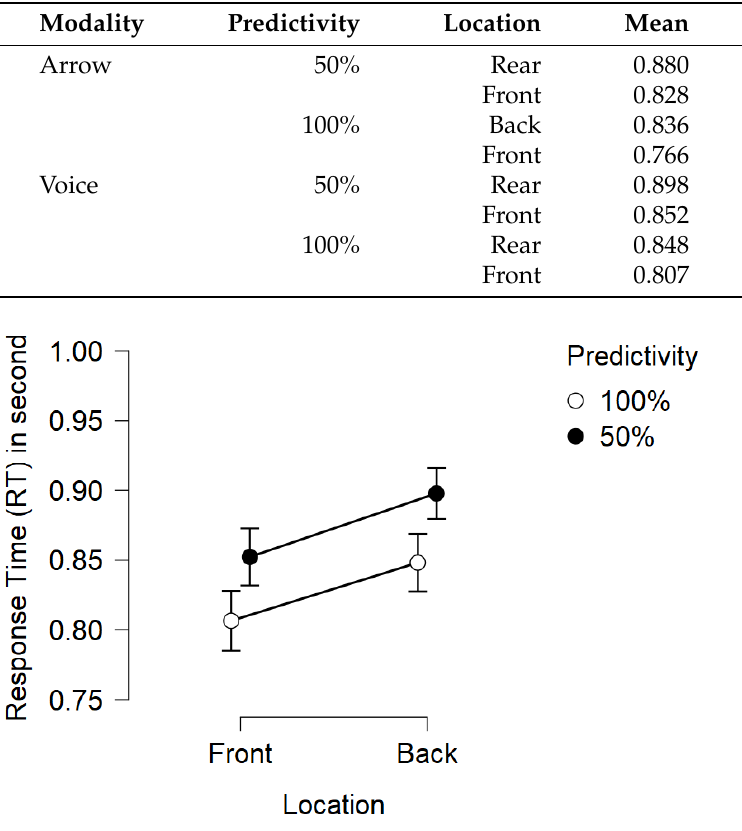
Table 4. Mean RT (in seconds) as a function of experimental factors for Ammunition-Choice.